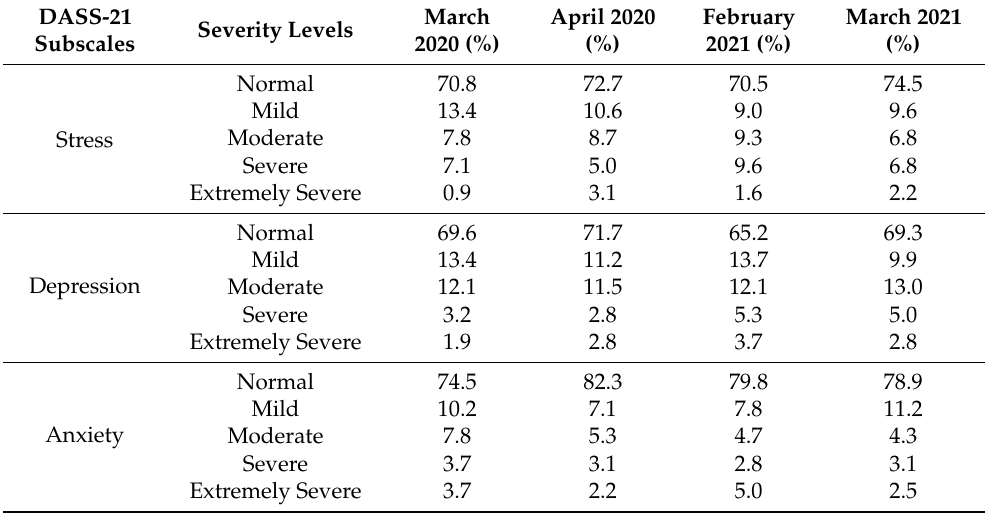
Table 1. Subsample distribution according to the severity of psychological symptoms and